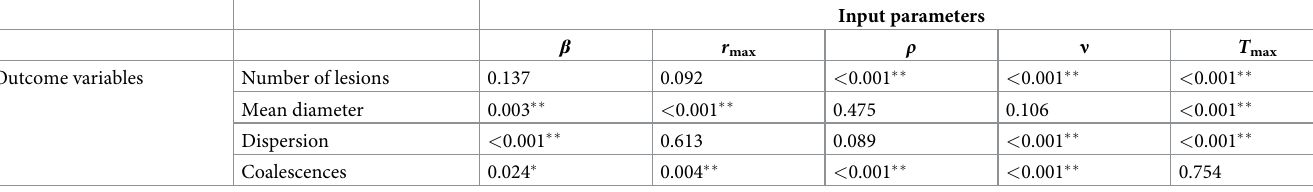
Table 5. Sensitivity analysis for the set of parameters: S = { ρ , β , r max } = {0.12 day -1 , 0.08 mm -1 , 0.68